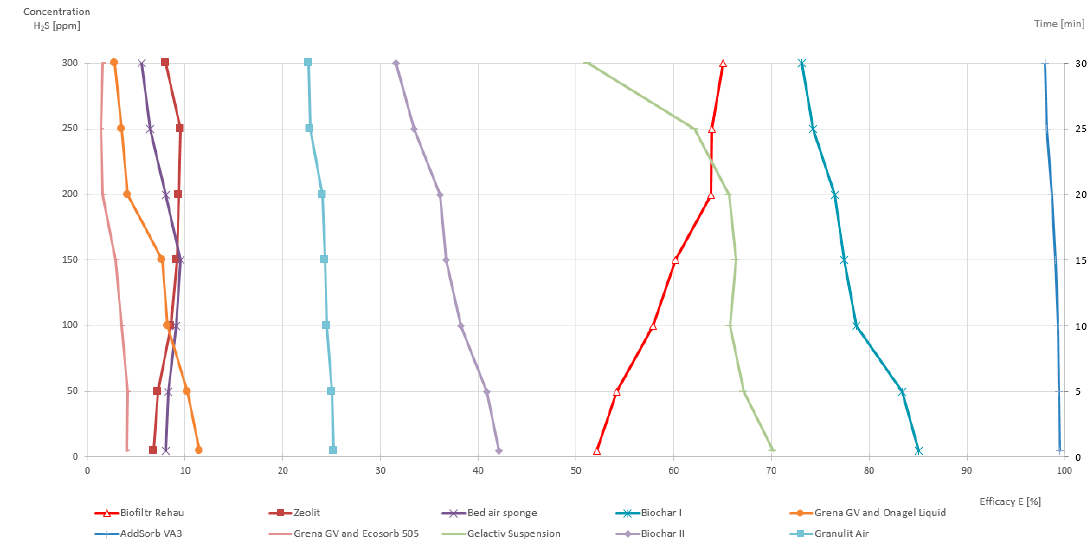
Figure 1. Efficacy of filtration materials.